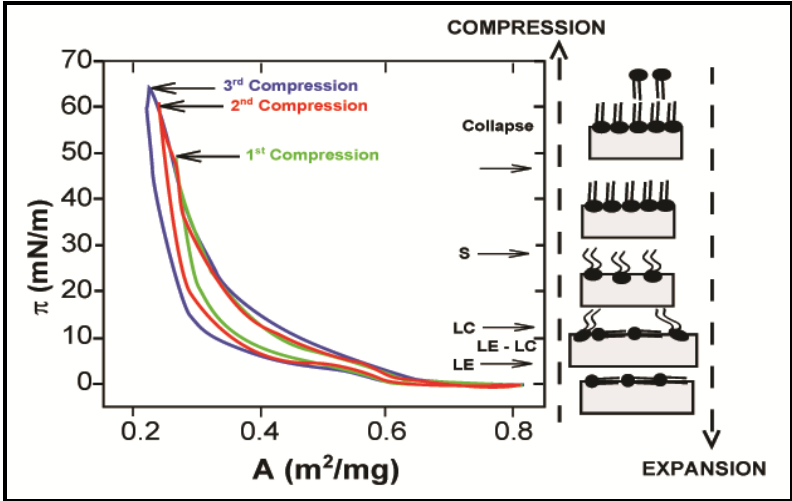
Figure 2. Hysteresis in π –A isotherms for DPPC monolayers at the air–water interface after continuous compression–expansion cycles at pH 7. The arrows indicate the equilibrium spreading pressure ( π ) and the transitions that take place in the monolayer e during a compression–expansion cycle between LE, LC and solid phases. Reproduced with permission from Rodríguez Niño et al. [26], Copyright (2008)